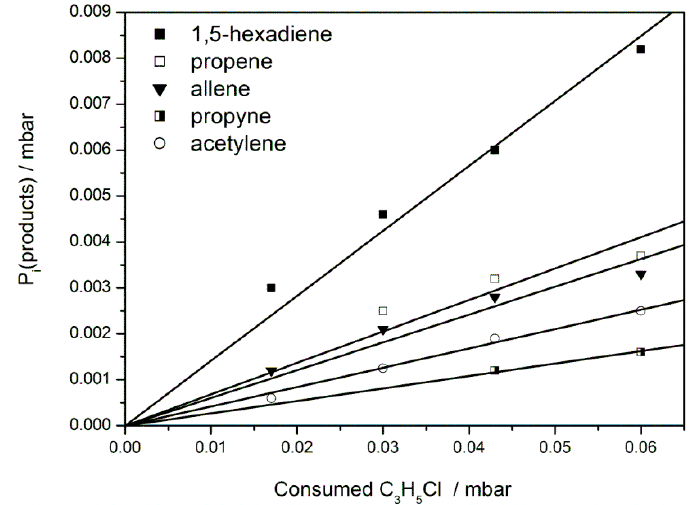
H + C H reaction: formation of products vs. consumption of 3 5 3 5